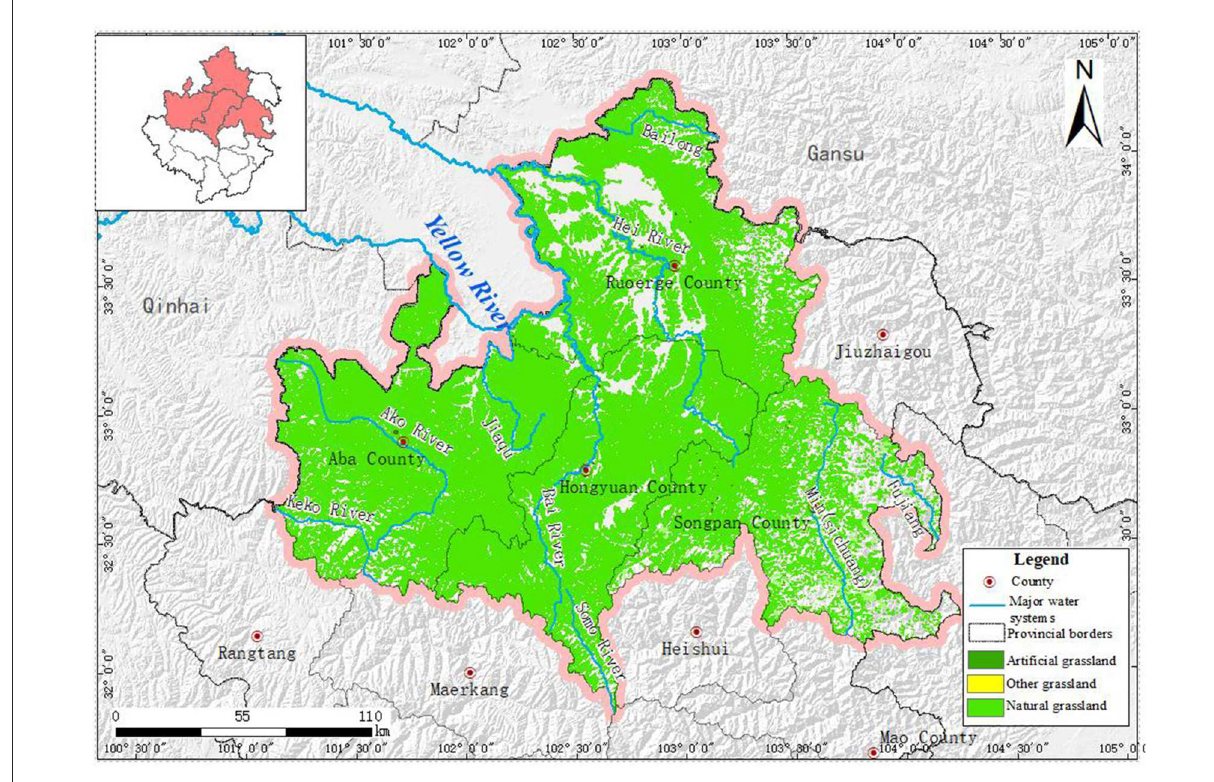
FIGURE2 Grassland resource distribution in the study